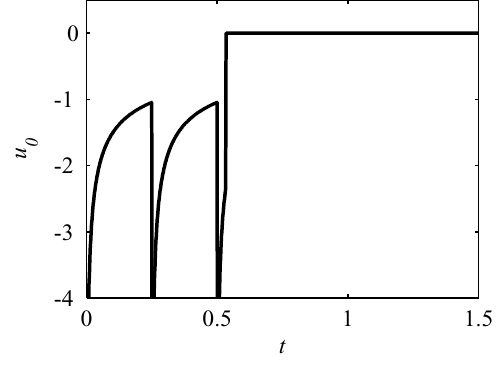
Fig. 4. Optimal control for ∆ = 0 . 25 .